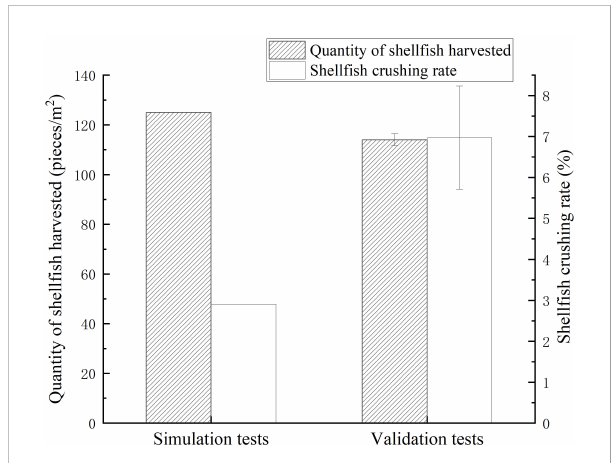
FIGURE 11 Results of shell fi sh harvesting simulation and veri fi cation test.